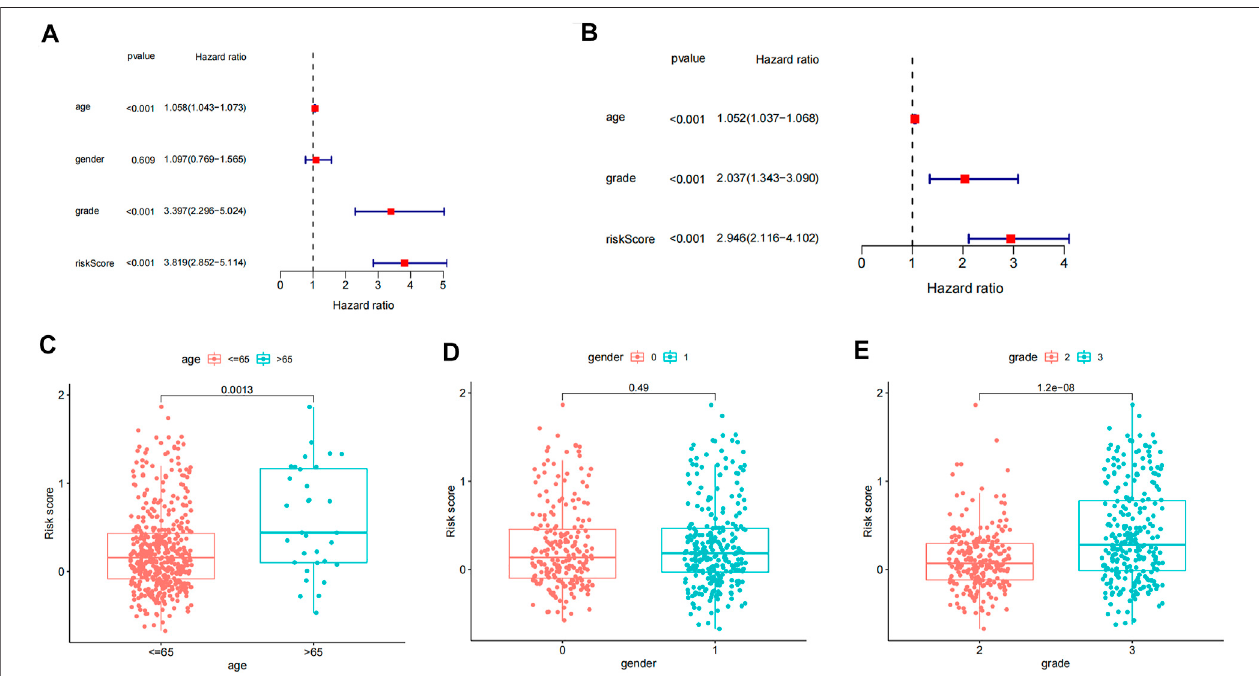
FIGURE 3 | Independent prognostic analysis and clinical correlation analysis. (A) Single-factor Cox regression analysis of different clinical characteristics and risk scores. (B) Multivariate Coxregressionanalysisofdifferentclinicalcharacteristicsandriskscores. (C – E) Differencesinage,gender,and tumorgradebetweenhigh-and low-risk